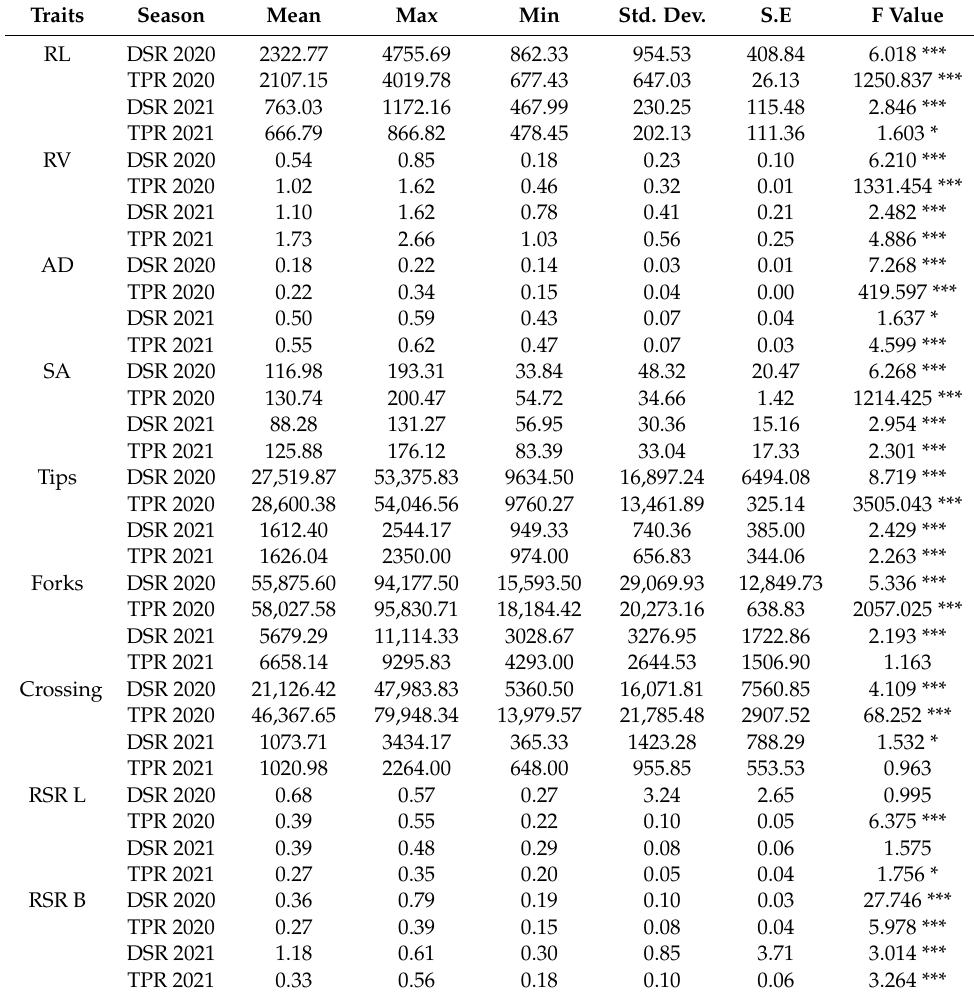
Table 4. Mean value of root architectural traits across different seasons under direct seeded and transplanted puddled system of rice cultivation.